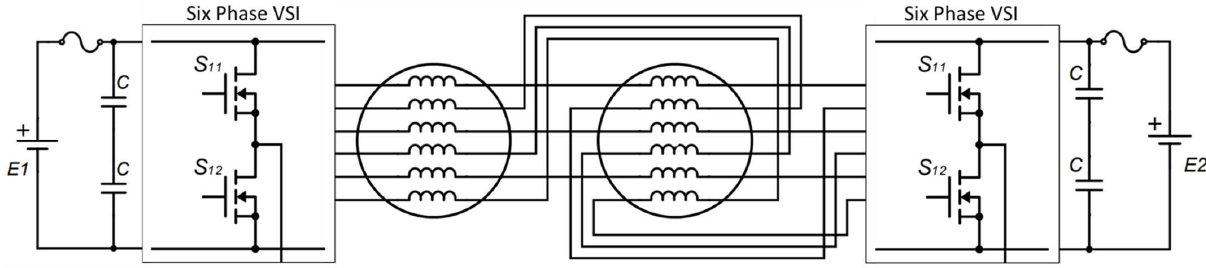
Figure 6. Fault tolerant six-phase dual-motor RIMM topology [43].